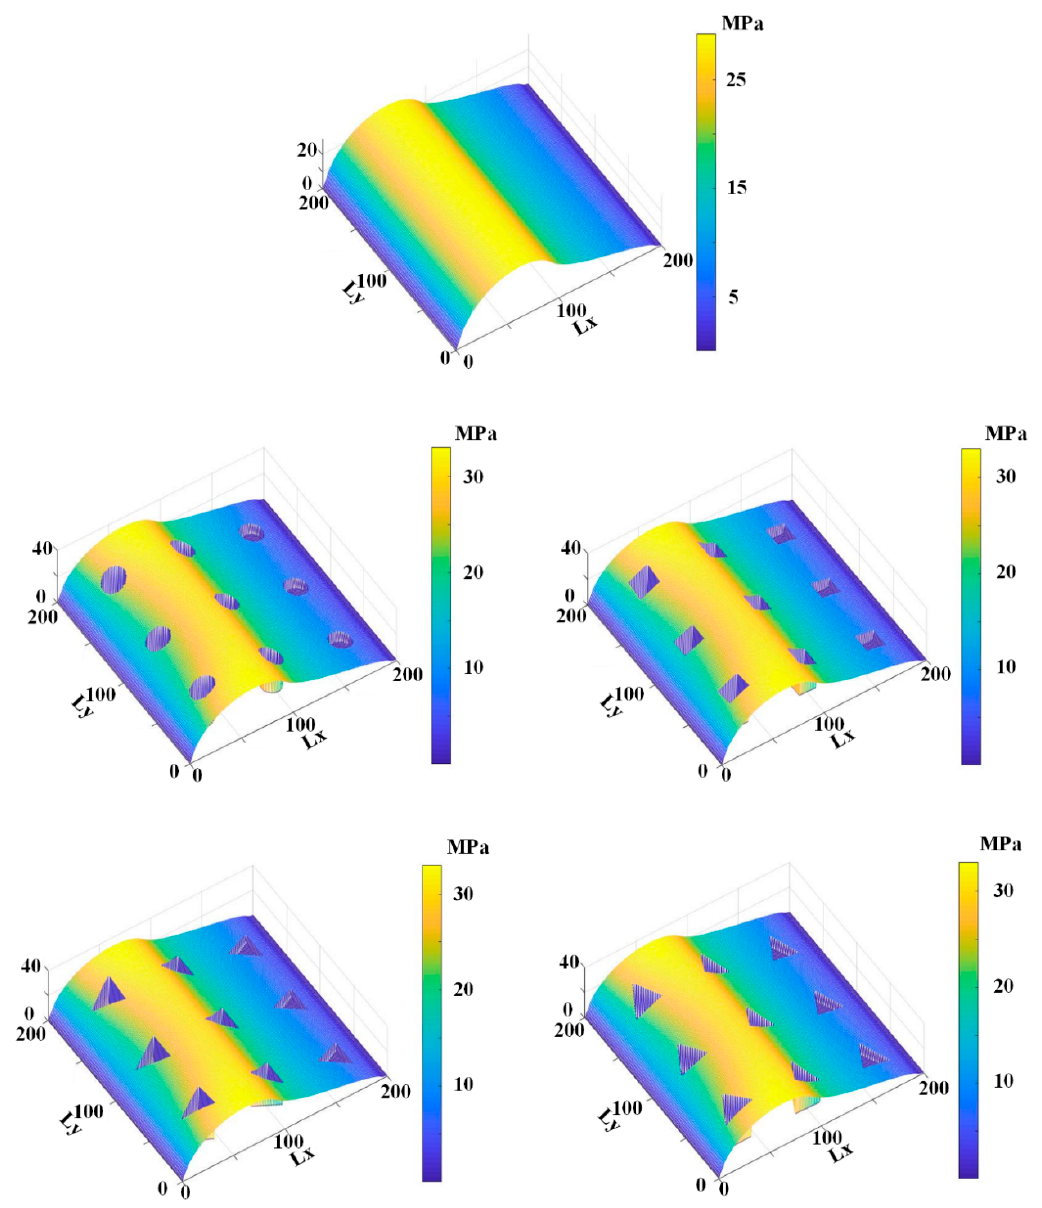
Figure 13. Asperity contact pressure during the outstroke.